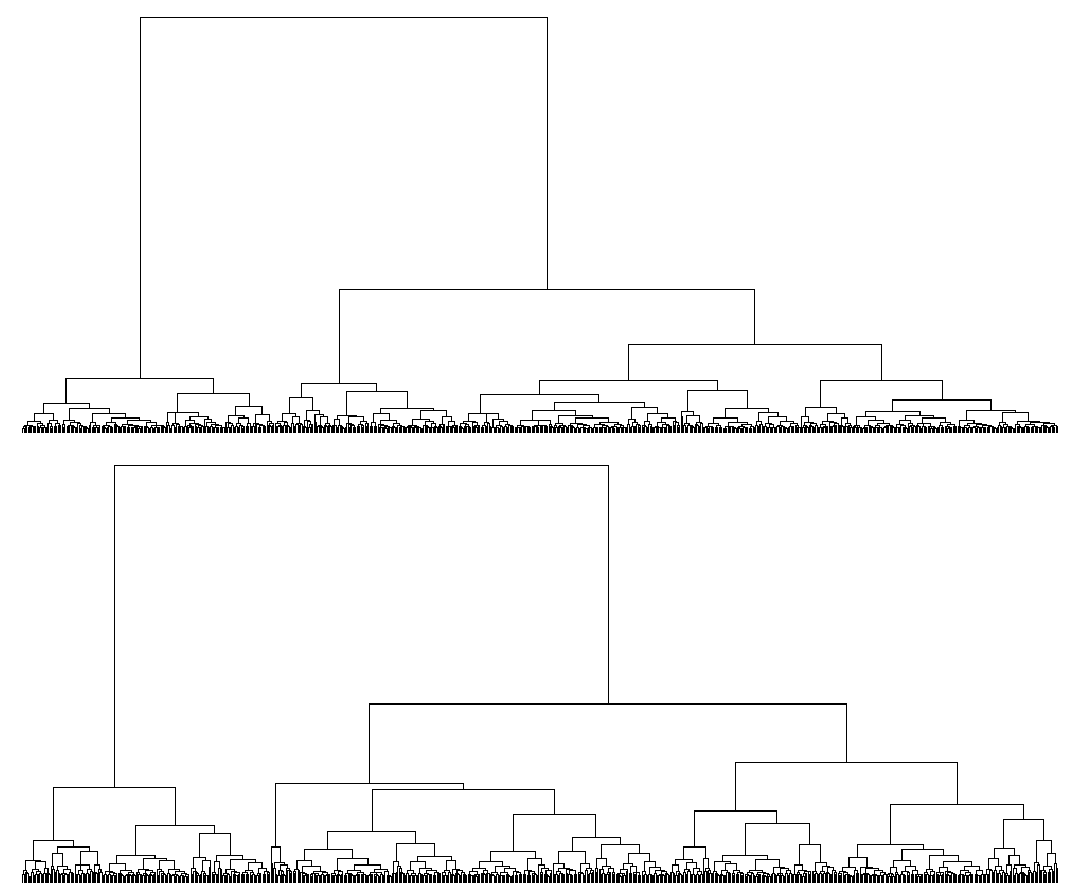
Figure 3. Ward dendrograms of the unweighted ( top ) and weighted ( bottom ) classifications.